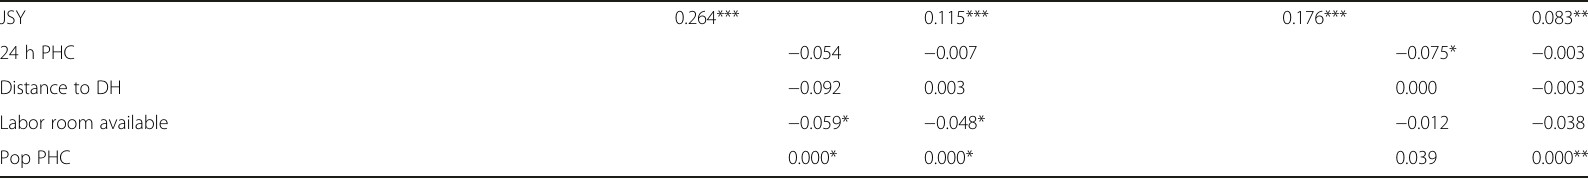
Table 2 Result of OLS model and spatial error model assessing determinants of IMR, High Focus States, 2010 – 2011